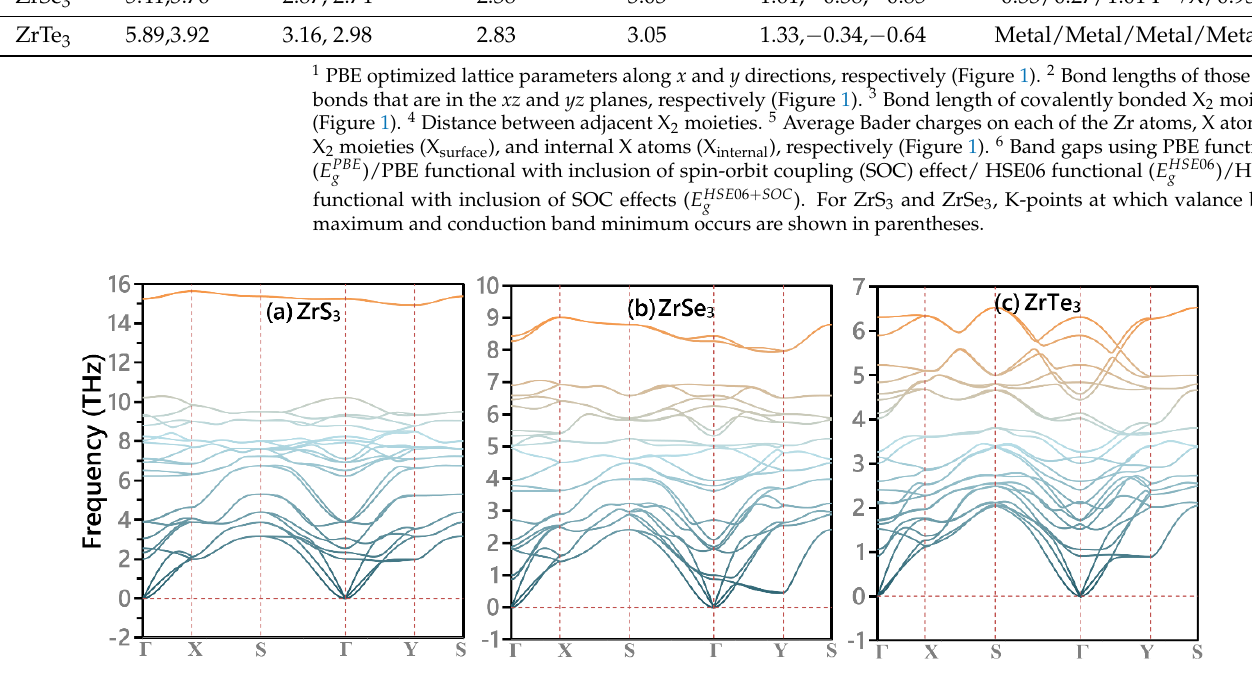
Figure 2. Phonon dispersion relations of the ZrS 3 , ZrSe 3 , and ZrTe 3